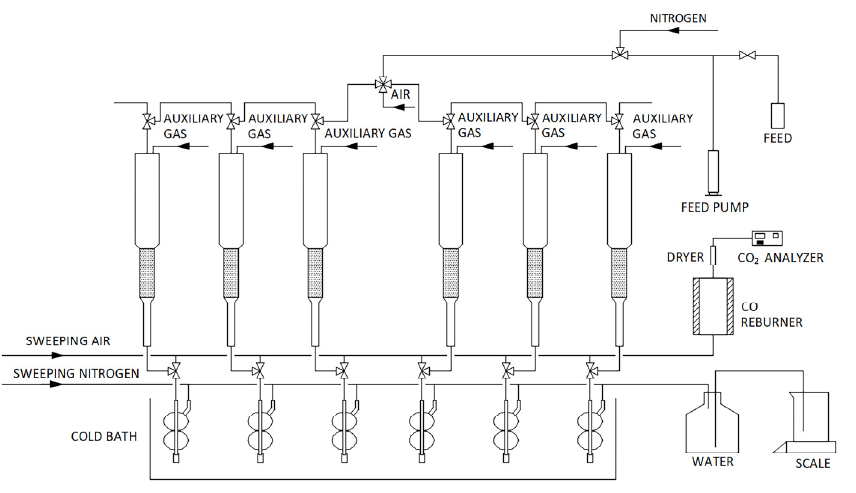
Figure 15. Fixed-bed reactor setup.